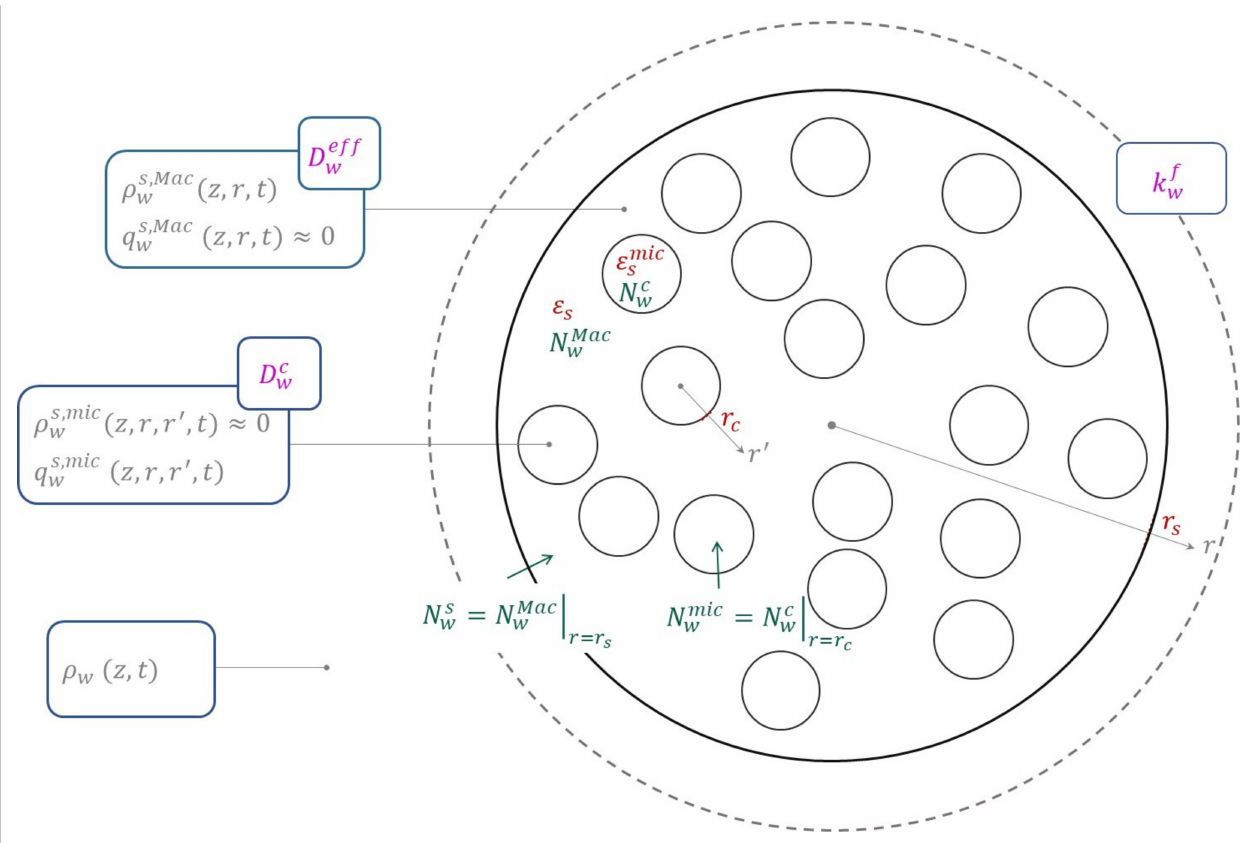
Figure 1. Diagram describing a spherical bi-disperse adsorbent particle giving information on the mass balance variables of the